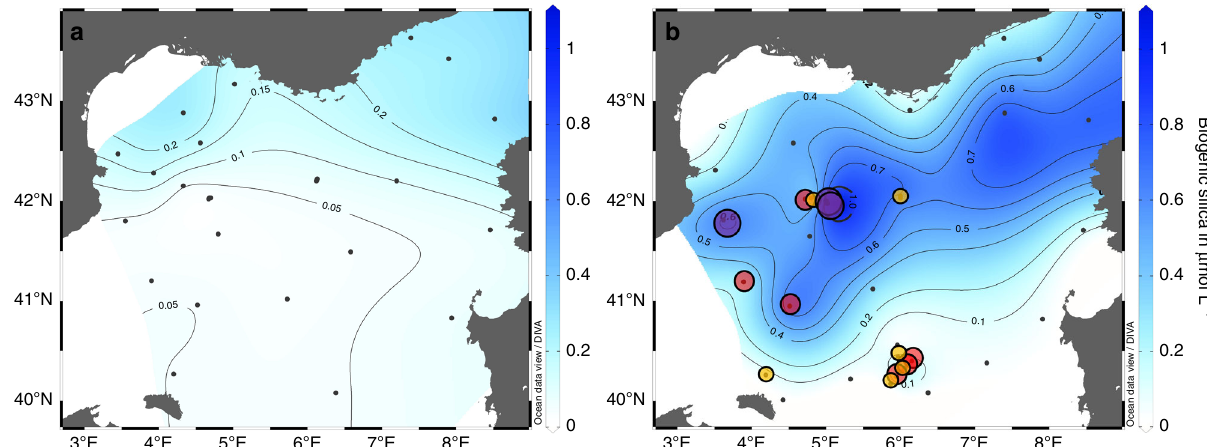
Fig. 2 Biogenic silica distribution during DeWeX and Minidiscus distribution and abundance. Surface distribution of biogenic silica in blue (Ocean Data View interpolation) during ( a ) leg 1 (03 – 21 February 2013) and ( b ) leg 2 (05 – 24 April 2013) of the DeWeX cruise. A spring bloom of Minidiscus (2 – 5 µ m) was reported during leg 2, at 17 out the 32 stations sampled, principally over the deep winter convection area and in an anticyclonic eddy South of the study area. Small yellow circles correspond to abundances comprised between 5000 and 100,000 cells L − 1 , medium red circles to between 100,000 and 1,000,000 cells L − 1 and large purple circles to between 1 and 6 million cells L − 1 . The northeastern area where BSi also accumulates during leg 2 is due to